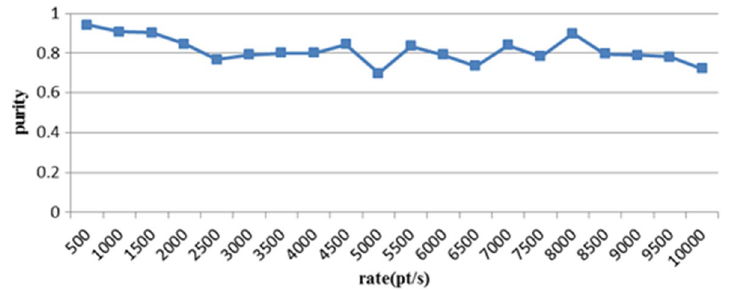
Fig. 19 Effect of stream data rate on purity over time. In the figure 19, the blue fold describes purity of clustering result at multipledifferent rates over time